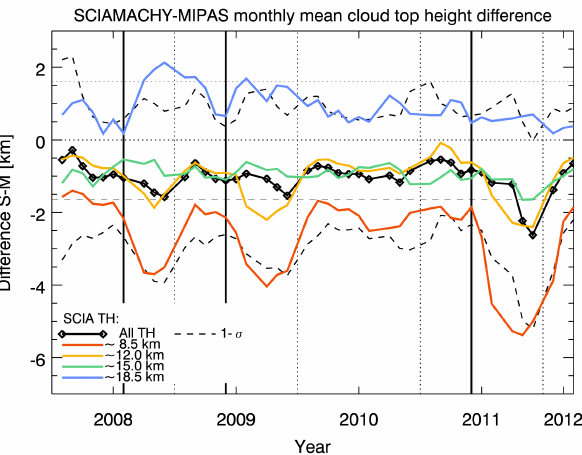
Figure 14. Scatter diagrams of co-located cloud top heights from SCIAMACHY and MIPAS measurements for April 2010. The colour-coded measurement pairs are divided into six latitude bands that are 30 ◦ wide: north/south polar, two midlatitude, and two trop- ical bands.